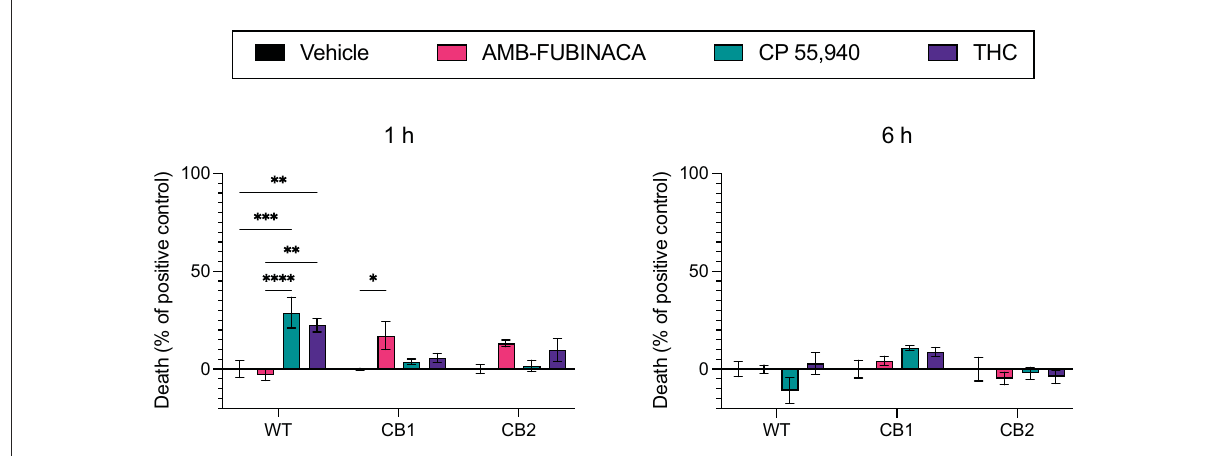
FIGURE6 LDH release over time after incubation with cannabinoids. Vehicle, AMB-FUBINACA, CP 55,940, or THC was bath applied to AtT20 cells expressing empty vector (WT), human CB1 (CB1), or human CB2 (CB2). LDH presence in cell media at 1 and 6h after incubation (as indicated above each graph) was measured, and normalized to total LDH (100%). n = 3; two-way ANOVA with Tukey’s multiple comparisons test within cell types, at each time point; * = p > 0.05, ** = p > 0.01; *** = p > 0.001; **** = p > 0.0001. See Supplementary Table 3 for overall ANOVA